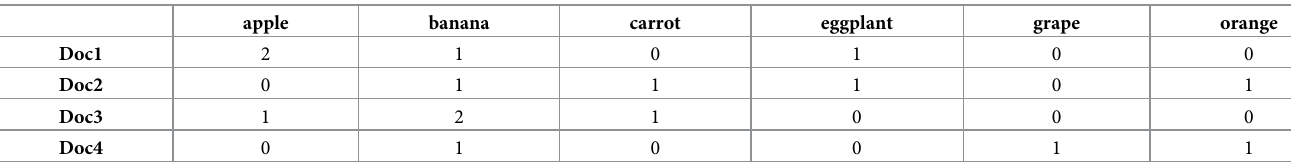
Table 1. Document–term matrix for the example four